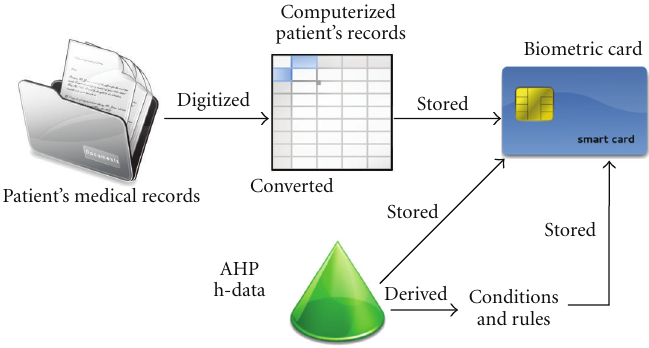
Figure 1: Conversion process of computerized patient’s records to